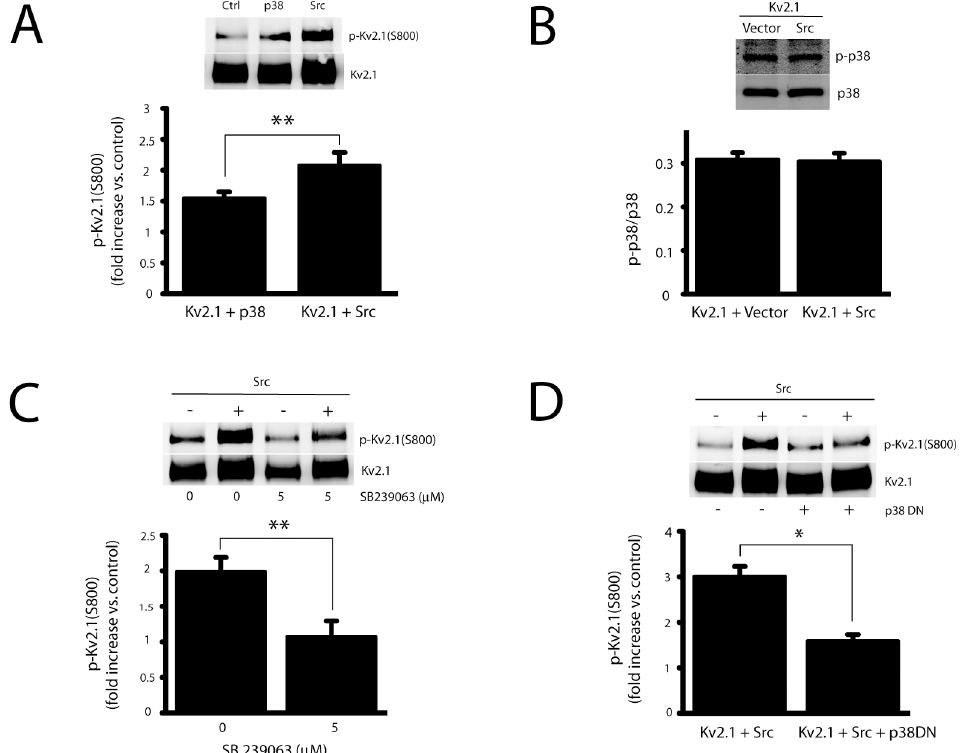
Fig 1. Src expression increases p38-dependent phosphorylation of Kv2.1 at S800. A, CHO cells were co-transfected with plasmid DNAs of Kv2.1 (10% of total DNA, see Methods), and either Src (15%) or p38 (15%). The membranes with immunoprecipitated Kv2.1 protein were co-probed with anti-Kv2.1 mouse monoclonal antibody and rabbit antibody specific against phosphorylation of Kv2.1 at residue S800. The levels of pKv2.1(S800) in Src- and p38-expressing CHO cells are expressed as the ratio of pKv2.1(S800) to total Kv2.1 protein, and normalized to the same ratio obtained from control cells (value of 1). The data represent mean ± SEM from 6 – 7 independent experiments ( ** p < 0.01, two-tailed, unpaired t test). B, Protein samples were harvested from Src- or control vector DNA-expressing CHO cells, the levels of total p38 protein (p38) and phosphorylated p38 protein (p-p38) in equal amounts of total cell lysates were detected by western blotting by using mouse antibody specific against p-p38 and rabbit antibody against total p38 protein. Results (mean ± SEM from 5 independent experiments) show that there is no change of p-p38 levels in Src-overexpressing CHO cells when compared with control cells. C, CHO cells were co-transfected with plasmid DNAs of Kv2.1 (10%), and either Src (15%) or control vector. Three hours later, transfected cells were treated with a specific p38 MAPK kinase inhibitor, SB 239063 (5 μ M). Kv2.1 protein was immunoprecipitated and separated. Immunoblot was performed and quantified as described in Fig 1A. Values (mean ± SEM from 3 independent experiments) represent the ratios of the level of pKv2.1(S800) to total Kv2.1 normalized to their respective controls (-Src, no drug and — Src plus drug; ** p < 0.01, two-tailed, paired t test). D, CHO cells were co-transfected with plasmid DNAs of Kv2.1 (10%) and either Src (15%), p38DN (15%) or control vector. Kv2.1 protein in transfected cells was immunoprecipitated, and quantified as described above. Values (mean ± SEM from 4 independent experiments) represent the ratio of the level of pKv2.1(S800) to total Kv2.1 normalized to respective controls, as in C ( * p < 0.01, two-tailed, paired t